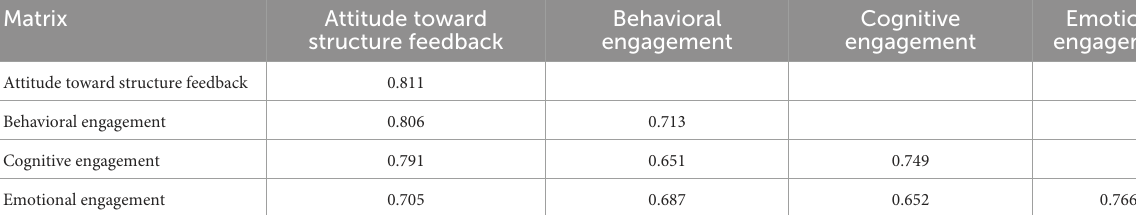
TABLE 8 Discriminant validity. Matrix